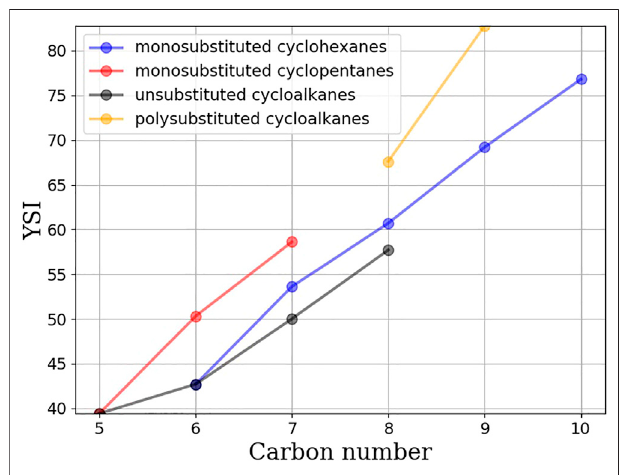
FIGURE 8 | YSI values for different classes of